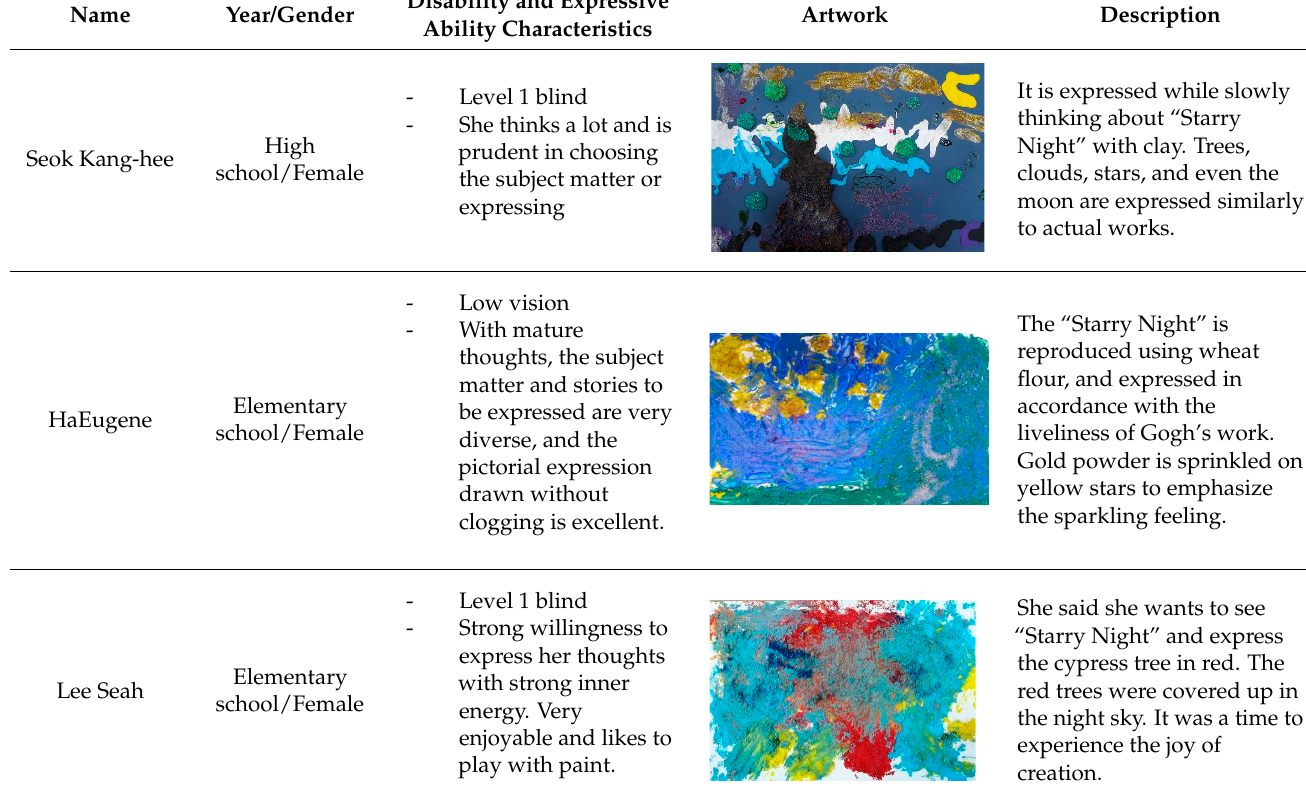
experience the joy of